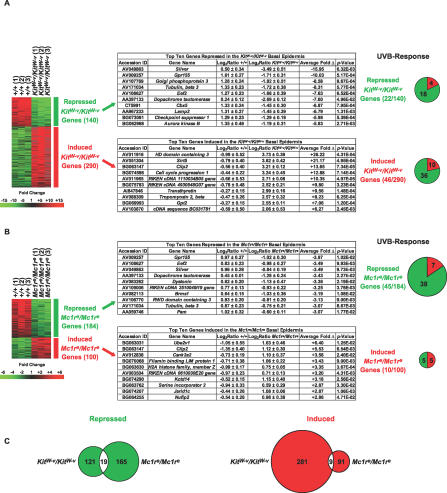
Proportion of Kit- and Mc1r-Dependent Genes Present in the General UVB Transcriptional Response in the Basal Epidermis of P2.5 MiceThe ordered columns represent replicate samples derived from (A) KitW-v/KitW-v and (B) Mc1re/Mc1re mice compared to normal (Mc1r+/Mc1r+; Kit+/Kit+) mice, and the rows represent log2 ratios for differentially expressed genes. Data are displayed as a pseudocolor heatmap where red, green, and black represent induction, repression, and no change, respectively, relative to the median. Gray represents missing data. The ratio fold-change is indicated by a scale bar. Genes are ranked by their average fold change (Δ) value. The average fold Δ value was obtained by dividing the average expression level of each gene in replicate mutant (KitW-v/KitW-v or Mc1re/Mc1re) samples by that in the corresponding normal control (Mc1r+/Mc1r+; Kit+/Kit+) samples. Average expression levels for the mutant and control groups are represented as log2 ratios ±SEM. The top ten ranked repressed and induced genes are listed along with their corresponding average fold Δ and Student's t-test p-values. In some cases, official mouse gene symbols are used, instead of the lengthier gene names. The fraction of differentially expressed genes in each KitW-v/KitW-v or Mc1re/Mc1re class that is also UVB responsive is represented by a colored pie chart (green, repressed; red, induced), with the size of the pie chart proportional to the percentage of Kit- or Mc1r-dependent genes that are UVB responsive. The overlap between the total number of Kit- and Mc1r-dependent genes (containing all 430 KitW-v/KitW-v and 284 Mc1re/Mc1re differentially expressed genes that were initially detected, regardless of UVB responsiveness) is shown in (C) for each of the repressed (green) and induced (red) classes.